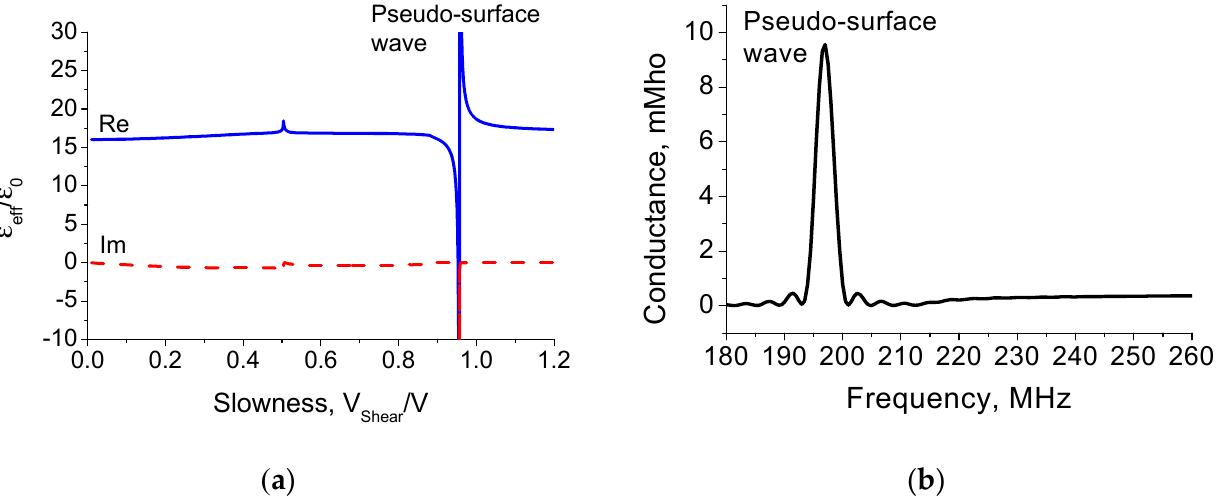
( b ) Figure 7. Normalized absolute value of acoustic wave displacement excited by the IDT consisting of five electrode pairs with period λ = 20 μ m and thickness h/ λ = 1%: ( a ) for the Z-cut and the pseudo-surface wave propagation direction along the X-axis, and ( b ) for the Z-cut and the SAW propagation direction along the X + 70°-axis on KTP.